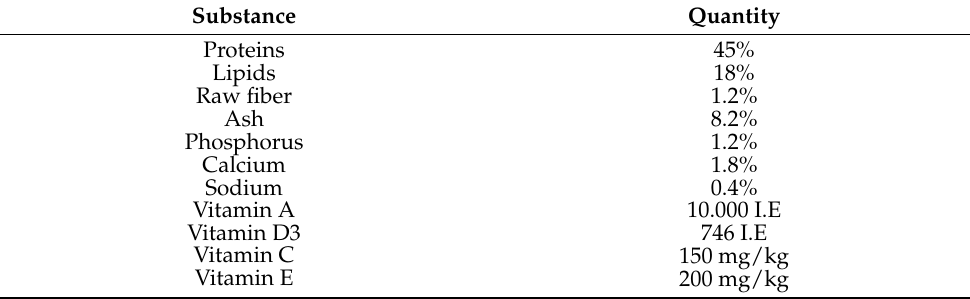
Table 1. The biochemical composition of Troco Pre Grower commercial